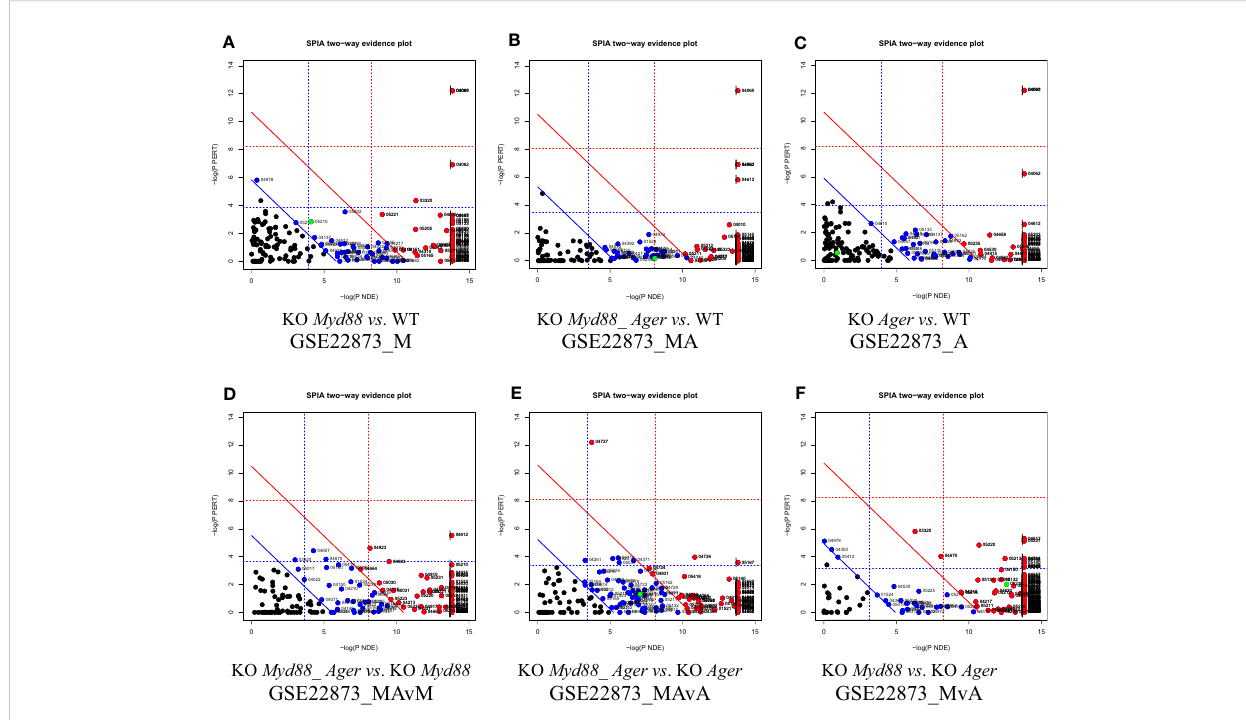
FIGURE 8 Two-dimensional probability evidence plots. A randomly assigned signaling pathway (green dot) located above or below the lines of signi fi cance level suggests the intuitive difference in fi ne distributions among data. (A) GSE22873_M; (B) GSE22873_MA; (C) GSE22873_A; (D) GSE22873_MAvM; (E) GSE22873_MAvA; (F)